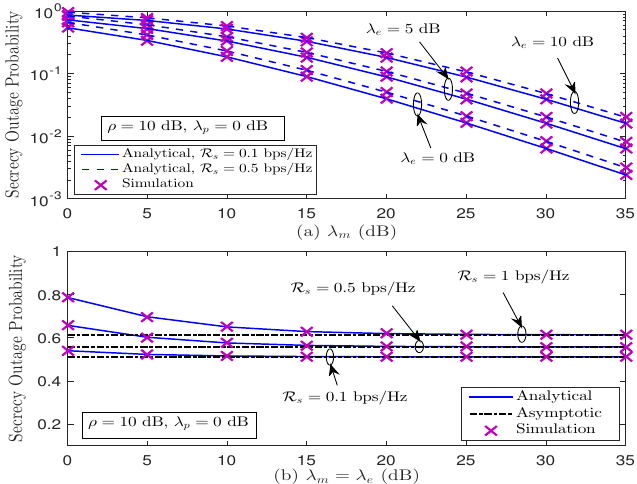
Figure 5. SOP performance for the considered system under Strategy